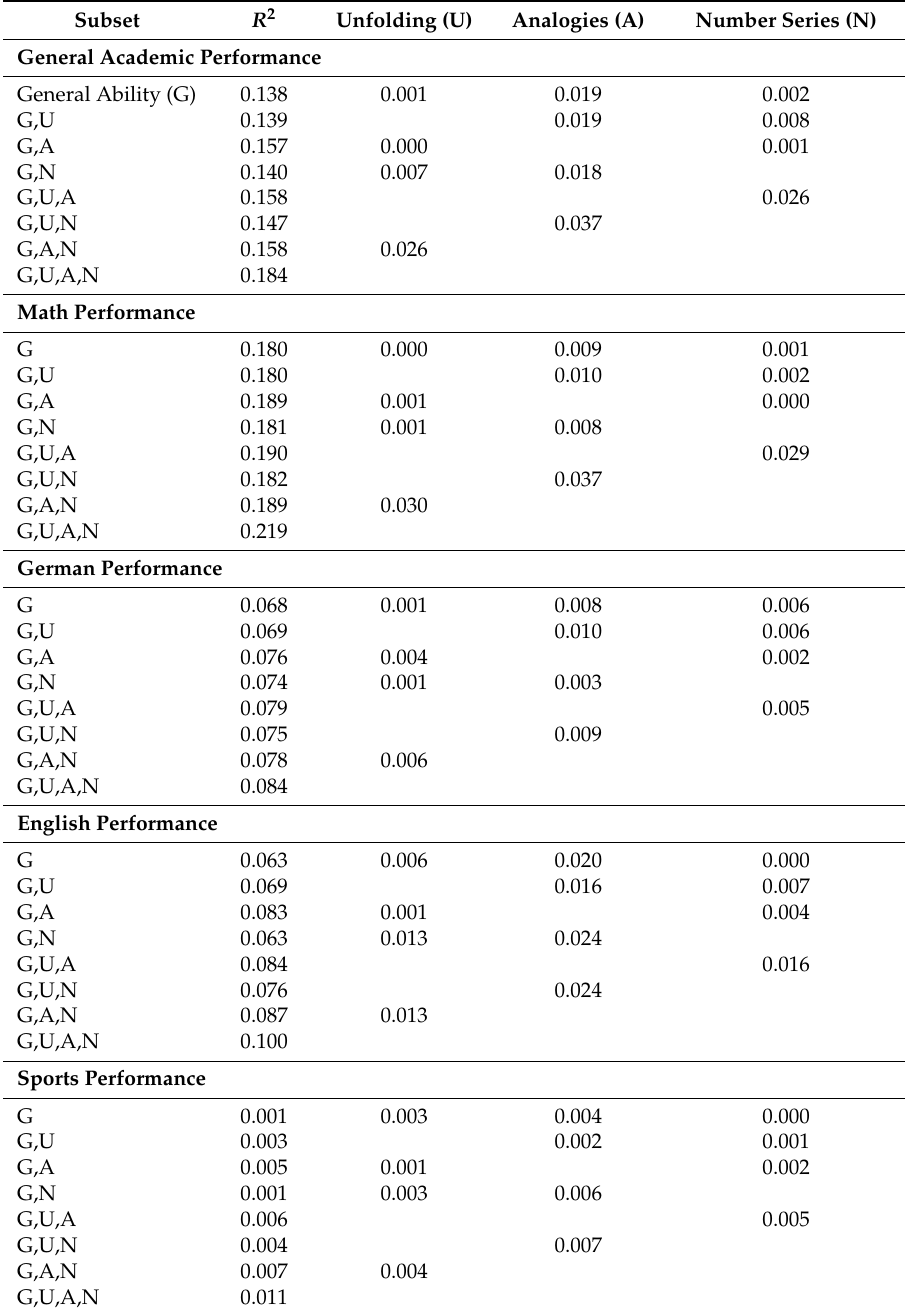
Table A1. Hierarchical regression